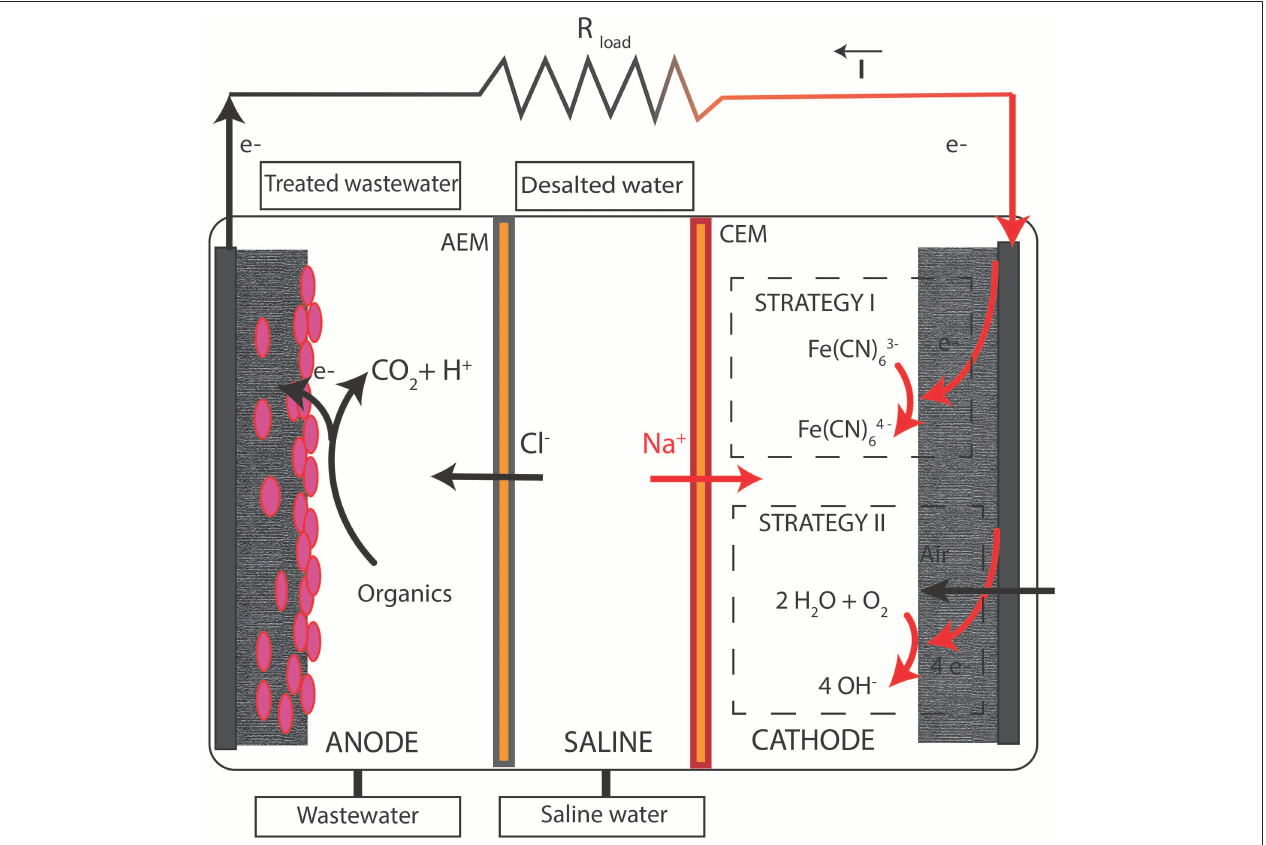
FIGURE 1 | Diagram of an MDC unit. AEM, anion exchange membrane; CEM, cation exchange